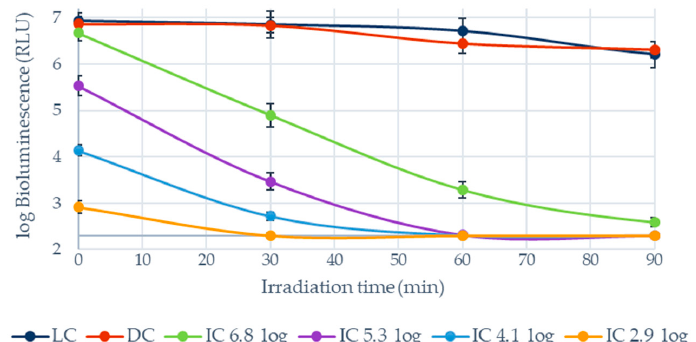
Figure 3. E. coli inactivation in PBS at different initial bacteria abundance. Tetra-Py + -Me was used at a concentration of 10 µM and the samples were irradiated with artificial PAR white light (380–700 nm) with an irradiance of 40 W m − 2 for 90 min. Legend: light control (LC), dark control (DC), and different initial abundances (IC). Values represent the mean of three independent experiments with two replicates each. XX axis cross the YY axis at 2.30 log RLU, representing the detection limit of the method.